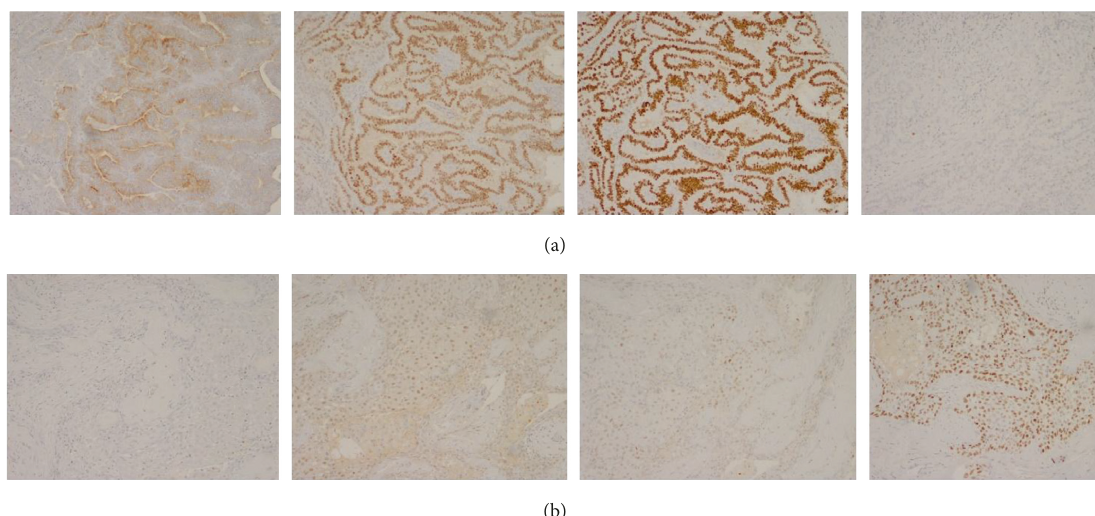
Figure 2: (a) From left to right are the papillary tall cell variant portion of thyroid cancer staining positive for thyroglobulin, PAX8, and TTF-1 and negative for p63. (b) From left to right are squamous cell area of thyroid cancer staining negative for thyroglobulin, weakly positive for PAX8 and TTF-1, and strongly positive for